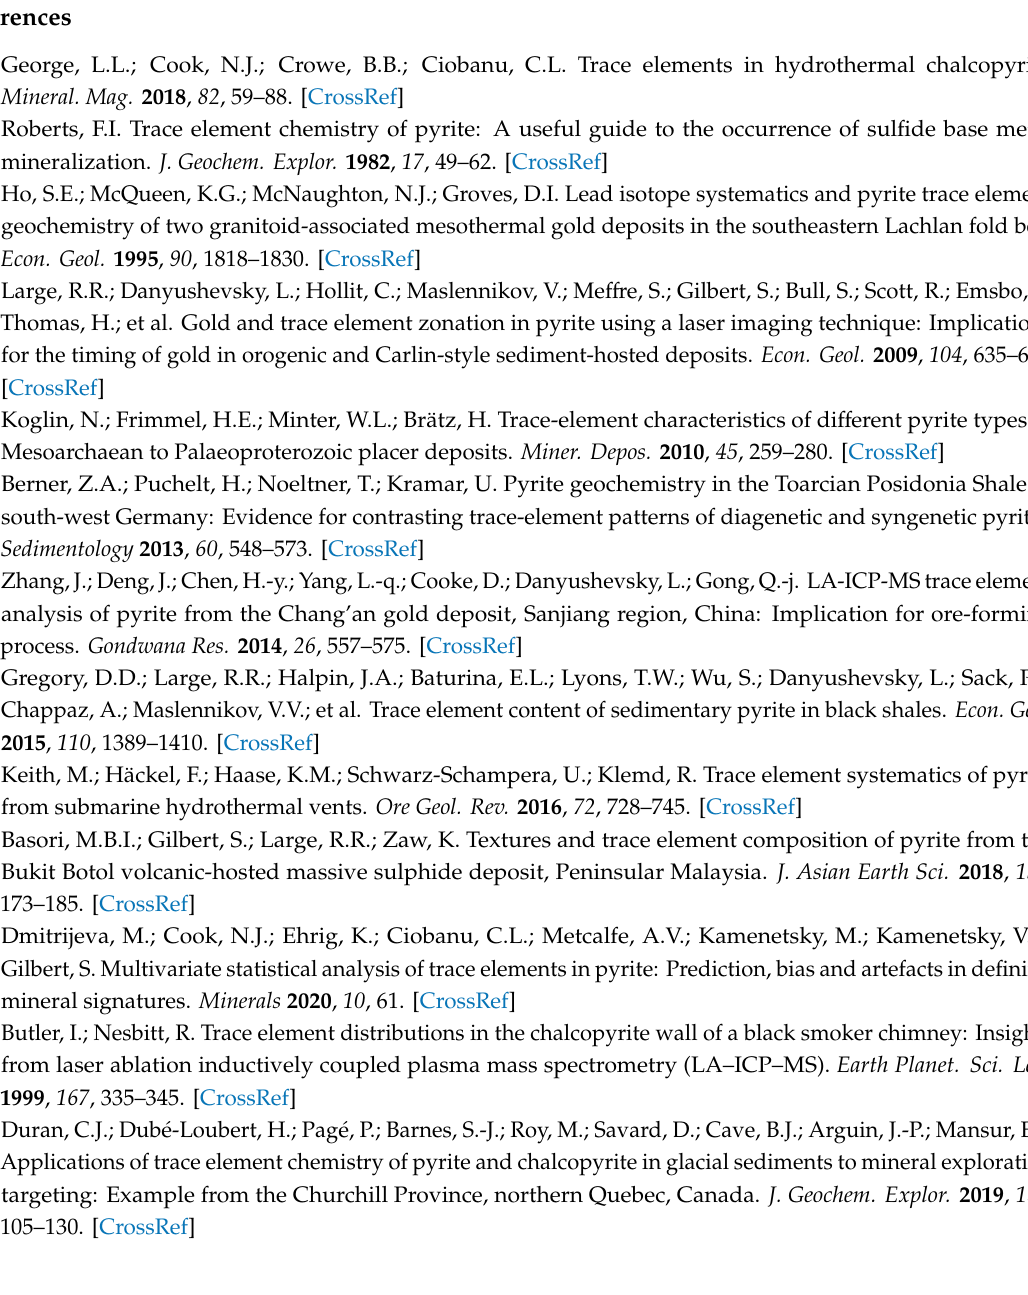
Figure S1: Violin-plot of three types of ores, Oktyabrsk deposit, Table S1: Trace-elements compositions of chalcopyrite from three types ores, Oktyabrsk